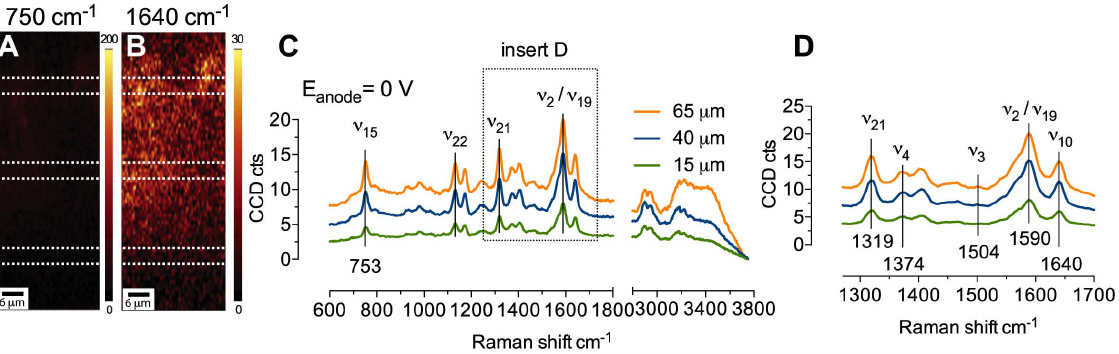
Figure 5. Biofilm sectional images and average RR spectra collected from electroactive biofilm at day 57 since inoculation, obtained after addition of 20 mM sodium acetate with the electrode poised at 0 V. Sectional maps are generated by binning the whole spectral information at (A) 750 cm 2 1 , and at (B) 1640 cm 2 1 , used here as markers of reduced and oxidized cyt c , respectively. Each spectrum was averaged within the areas indicated by the dotted lines, representative of three biofilm locations, that is, top, middle, and bottom, respectively at a distance of 65, 40, and 15 m m from the electrode surface (not visible at the bottom of the spectral sectional maps). Prior recording the RR spectra, the biofilm was exposed to the potential of 0 V vs. Ag/AgCl for 40 minutes to allow stabilization of the current profile (profiles shown in Figure S2C).